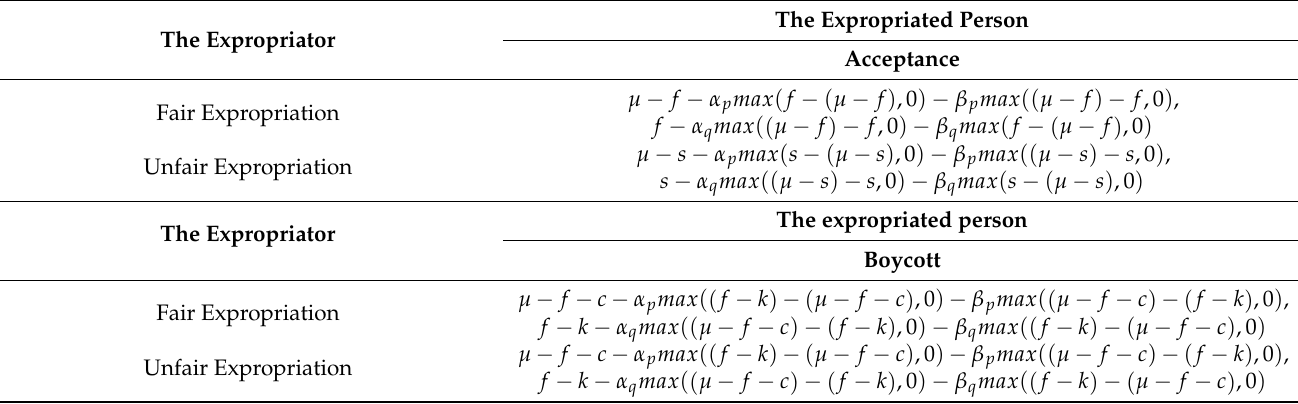
Table 3. The interactive fairness game matrix of urban housing expropriation